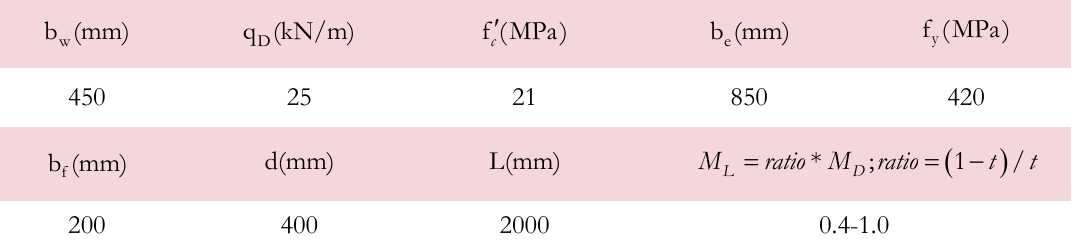
Table 2: The nominal parameters of this